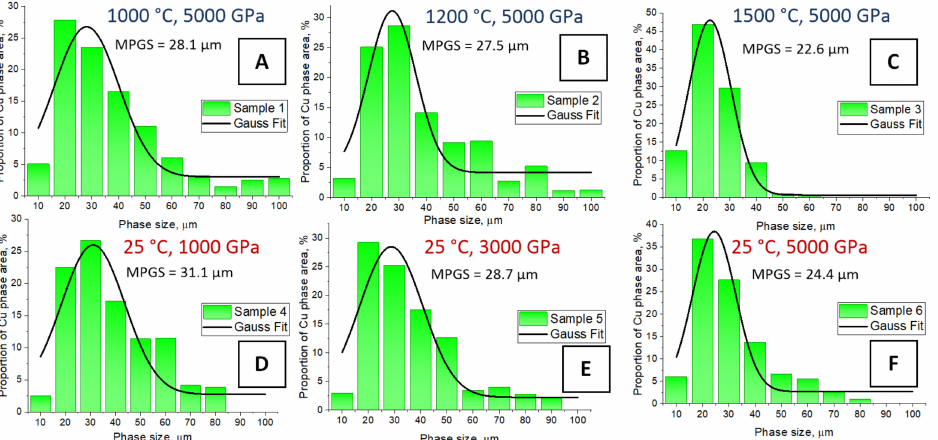
Figure 6. Distribution of the Cu phase sizes of the W–Cu samples of the I type: ( A )—Sample 1, ( B )—Sample 2, ( C )—Sample 3, ( D )—Sample 4, ( E )—Sample 5, and ( F )—Sample 6.